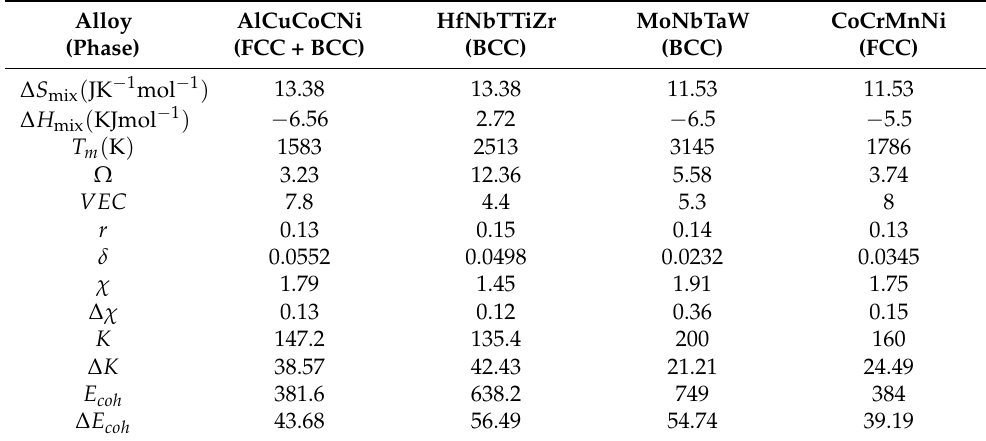
Table 2. Four representative entries of the dataset after standardization. Each entry has eight input